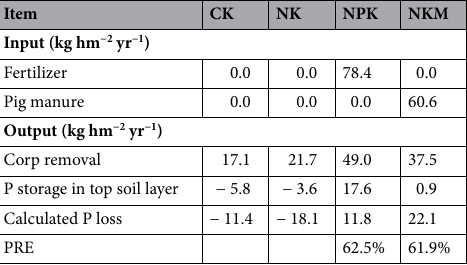
Table 2. Annual P balance over 35-year experimental period (1981–2015). CK: unfertilized control; NK: mineral fertilizer NK; NPK: mineral fertilizer NPK; NKM: mineral fertilizer NK combined with pig manure, PRE: phosphorus recovery efficiency.